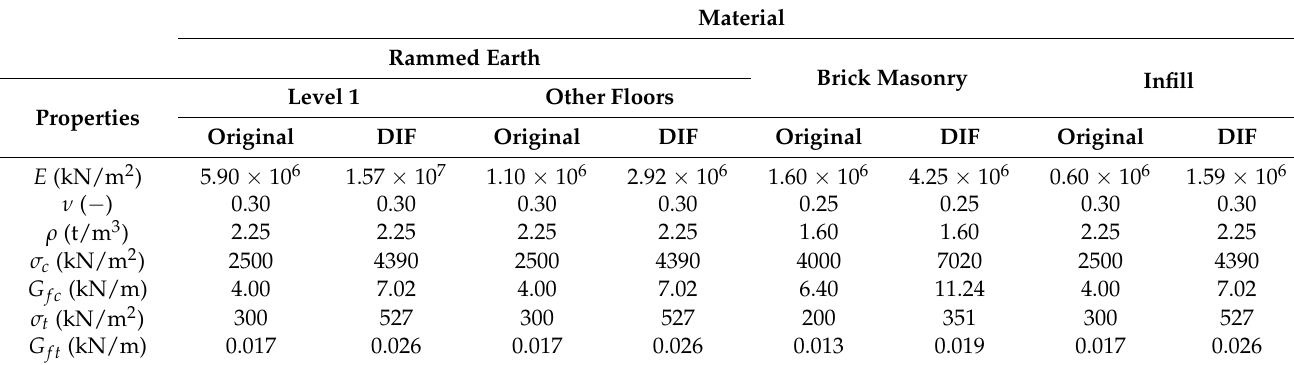
Table 2. Material properties with and without considering the dynamic increase factors